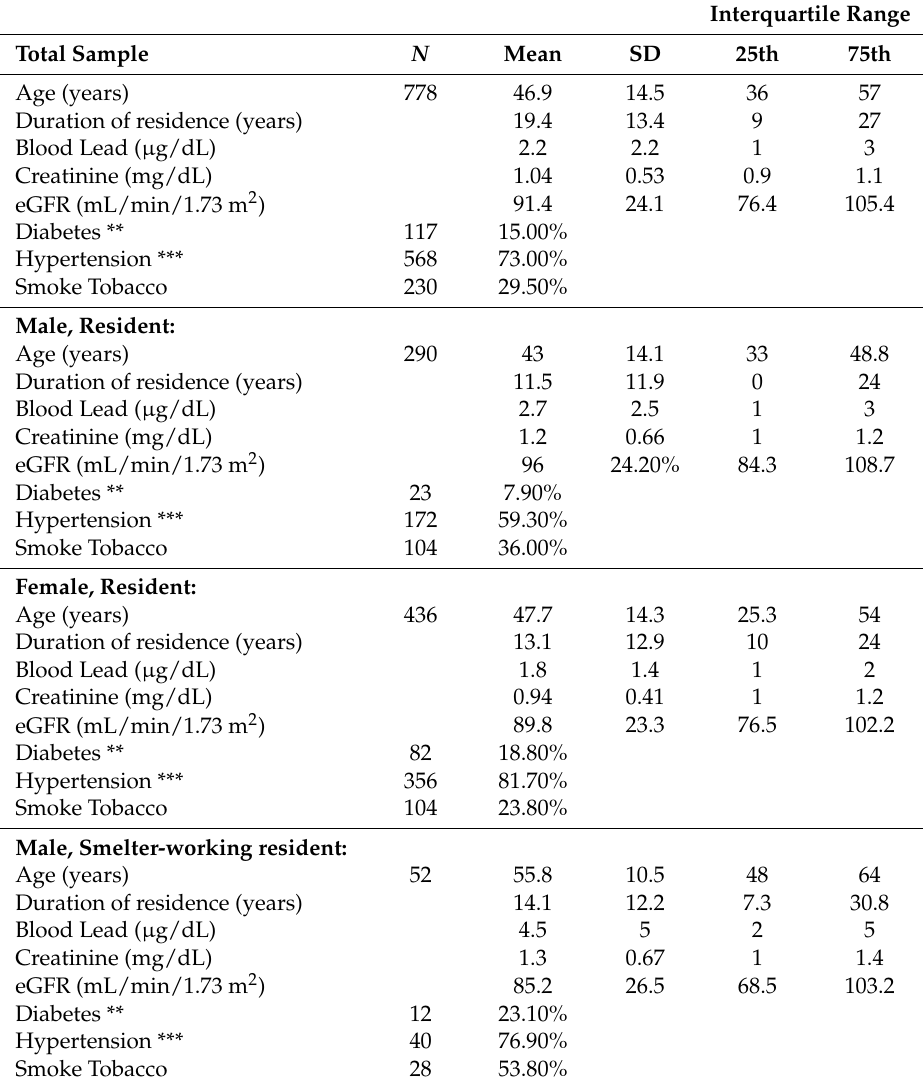
Table 1. Study group